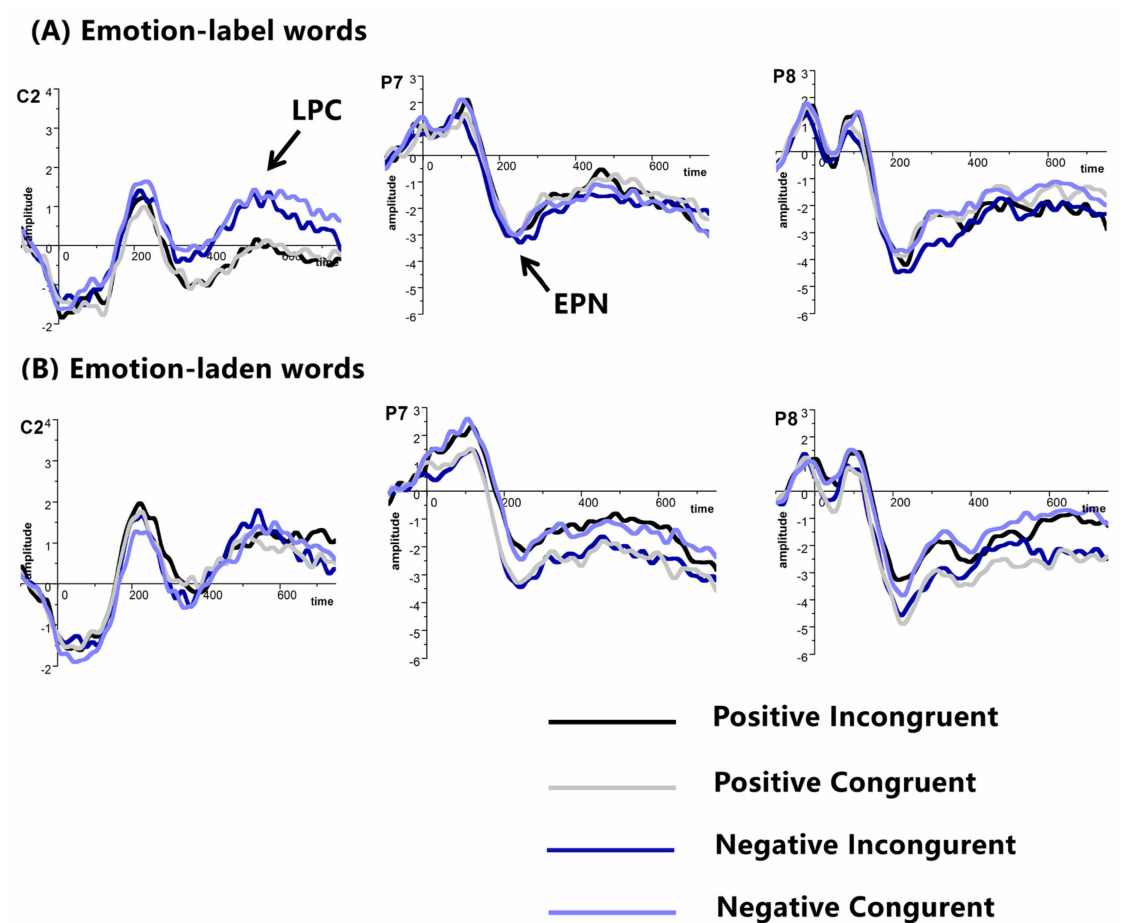
Figure 2. Grand average ERPs of EPN and LPC at selected electrodes with ( A ) emotion-label words, and ( B ) emotion-laden words as primes in Experiment 1, amplitude ( µ V), time